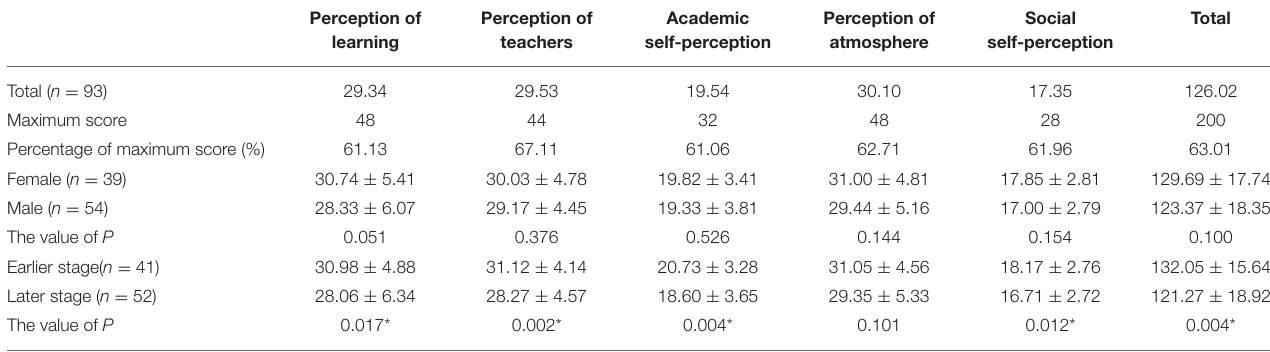
TABLE 1 | Comparison of DREEM score between sex and